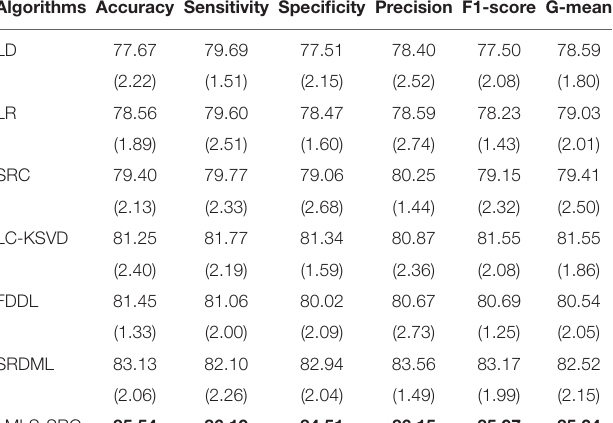
TABLE 6 | The comparative test results (with standard deviation) in four-class classification task. Algorithms Accuracy Sensitivity Specificity Precision F1-score G-mean